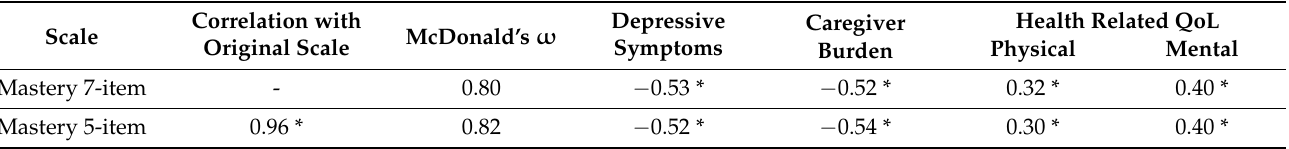
Table 3. Reliability and Validity of Original Mastery and Shortened Mastery